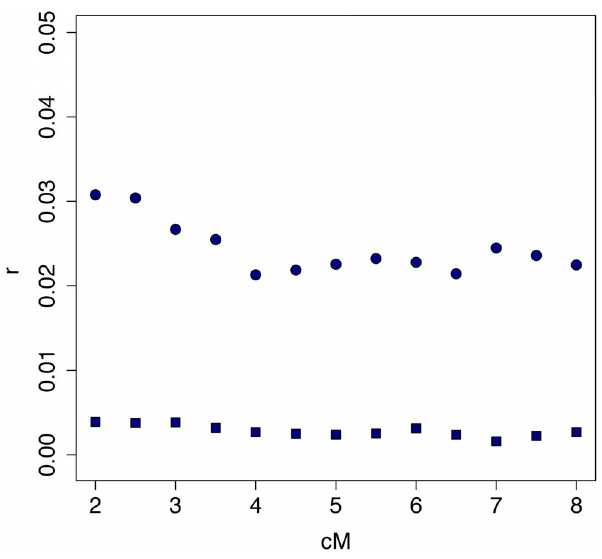
Figure 8. Sved’s [17] measure for the correlation of heterozy- gosity between blocks of 50 SNPs as a function of the recombination rate between the blocks. The squares show the genome-wide average for the Yoruba population (calculated by Sved). The circles pertain to the 10 cM region of Chromosome 8 that has the highest density of LRLD patches identified by our method. The difference is highly significant ( p , 10 2 3 ).